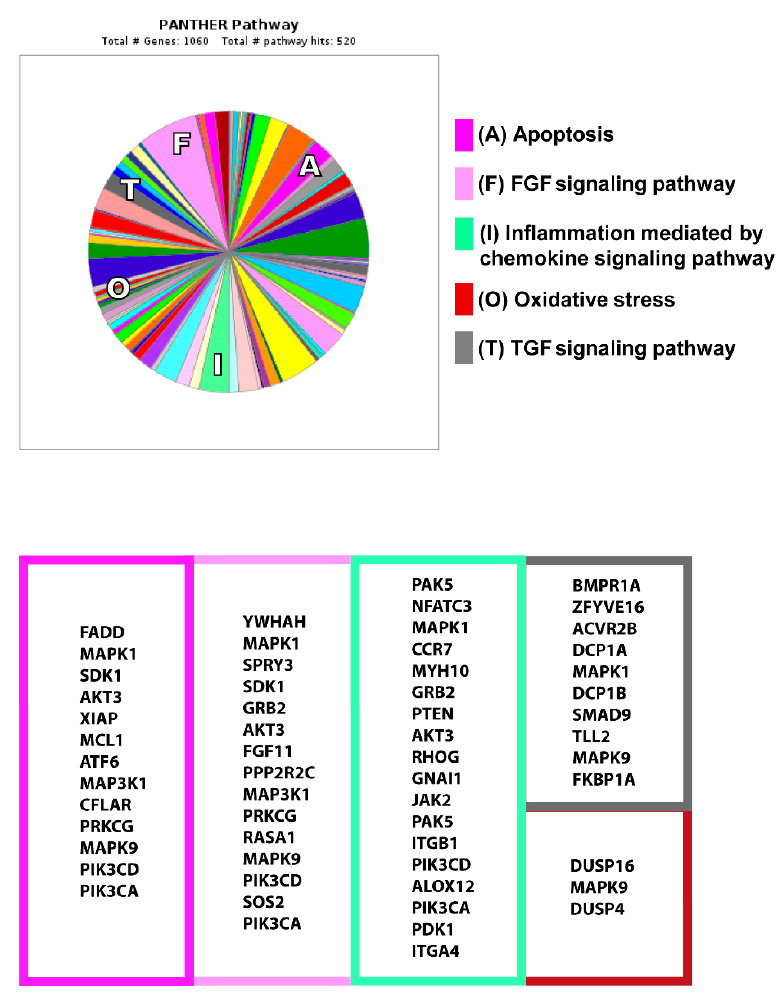
Figure 9. In silico analysis of miR-320a targets. PANTHER analysis showed the miR-320a predicted target genes involved in different pathways induced under ischaemia and reperfusion, such as apoptosis (dark pink), FGF (light pink) and TGF signalling (grey) pathways, inflammation (green) and oxidative stress (red).